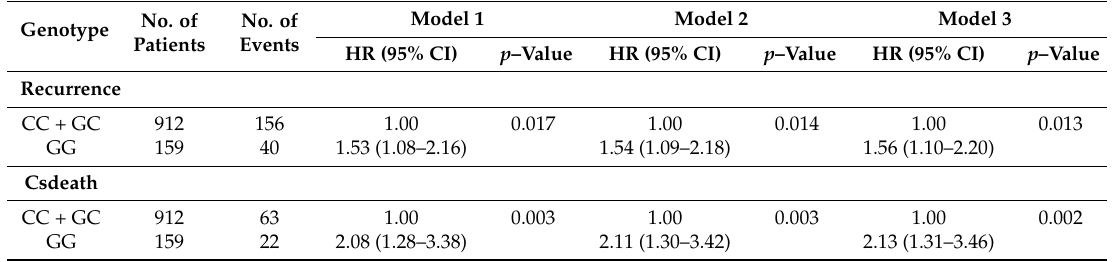
Table 5. rs2910164 GG genotype increased risk of stroke recurrence and Csdeath.